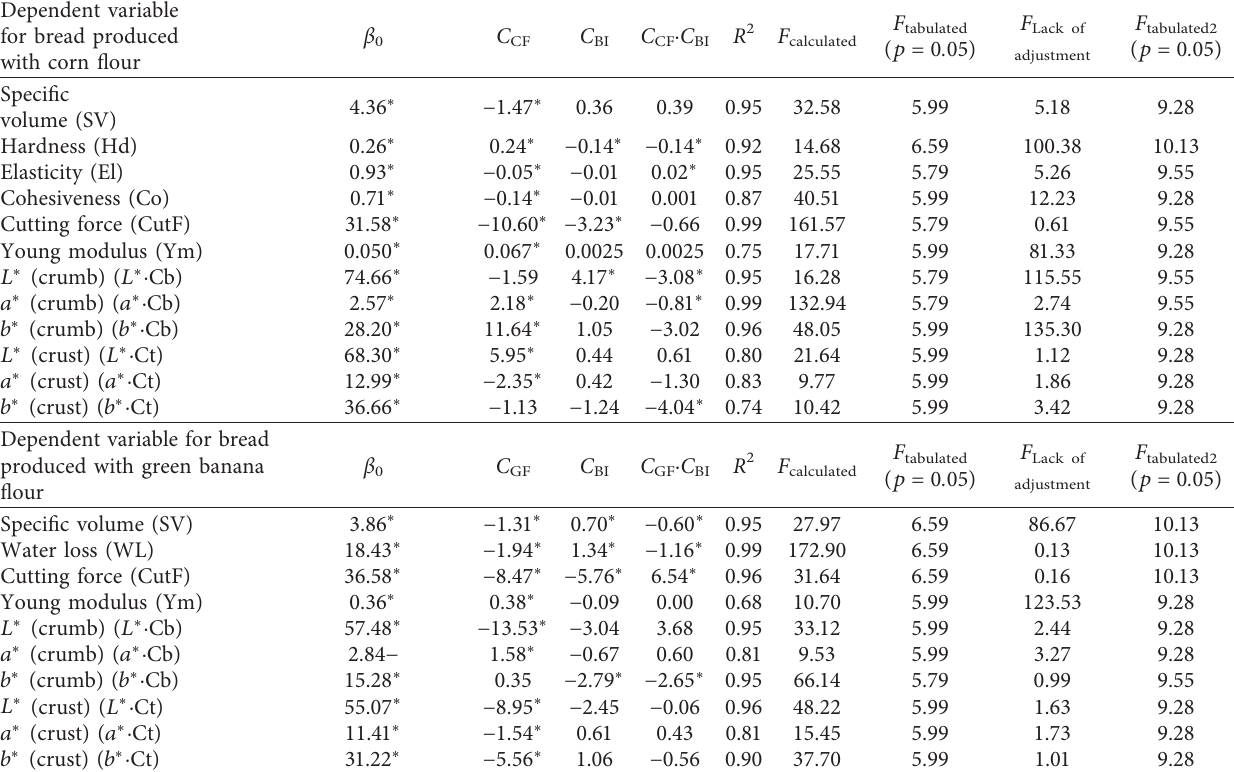
Table 3: Regression coefficient and ANOVA for the different dependent variables evaluated as a function of the independent variables, corn flour concentration ( C CF � g/100 g total flour), green banana flour concentration ( C GF � g/100 g total flour), and baking improver con- centration ( C BI � g/1200g of total